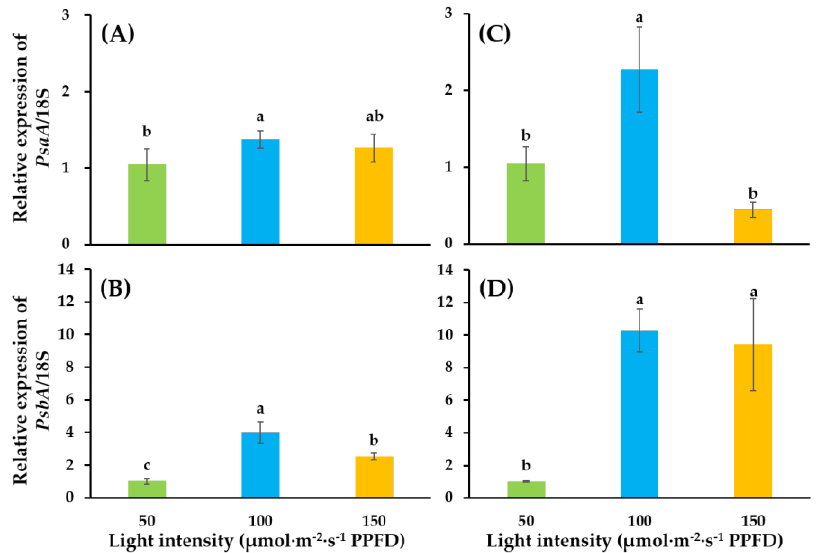
Figure 5. Relative expressions of PsaA and PsbA genes in ‘SS’ ( A , B ) and ‘SD’ ( C , D ) grafted onto the ‘B-Blocking’ rootstock. The bars among treatments represent the mean ± SEs of technological replicates ( n = 3). According to the Duncan test, lowercase letters at p ≤ 0.05 indicate significant differences between different treatments.